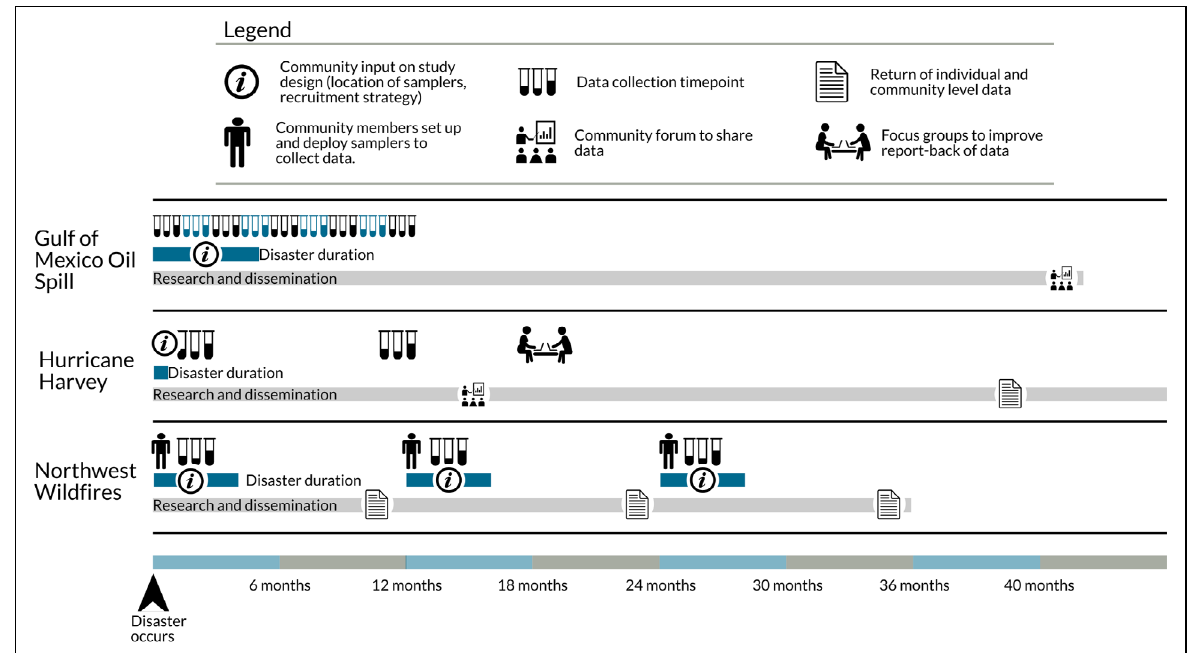
Figure 2 General timeline of community-engaged disaster research (CEnDR) case studies. The disaster duration refers to the initial event and does not encompass disaster recovery. Icons indicate areas of community engagement (forums, outreach via research dissemination), participation (focus groups, data collection), and involvement (community input on study